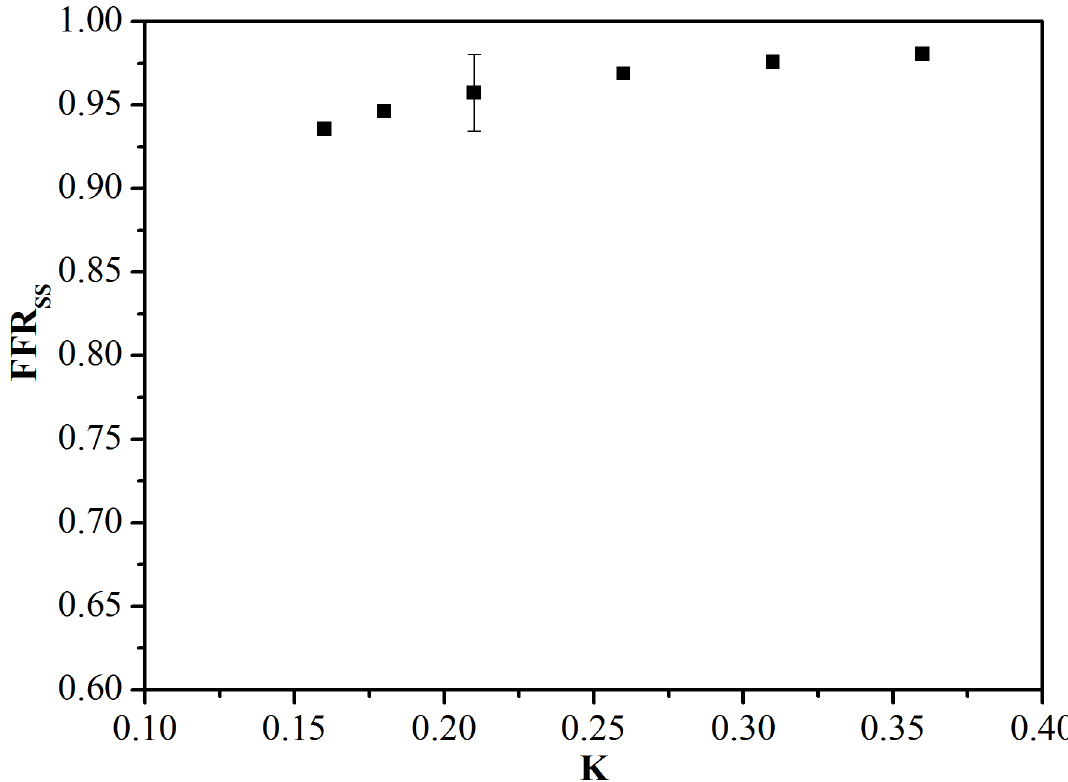
Fig 7. Sensitivity of FFR SS with a varied